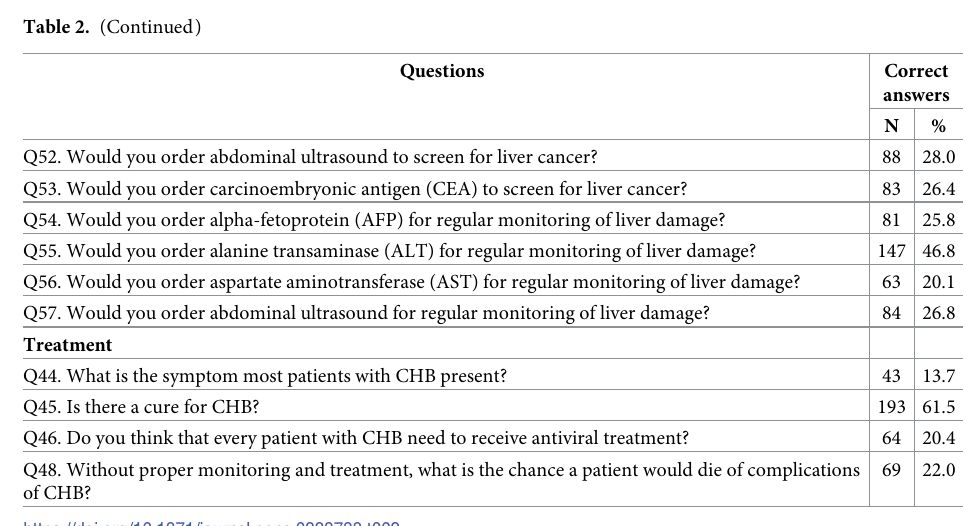
eight knowledge categories are presented in Table 4. Among the eight knowledge categories, median scores were lowest for CHB monitoring and